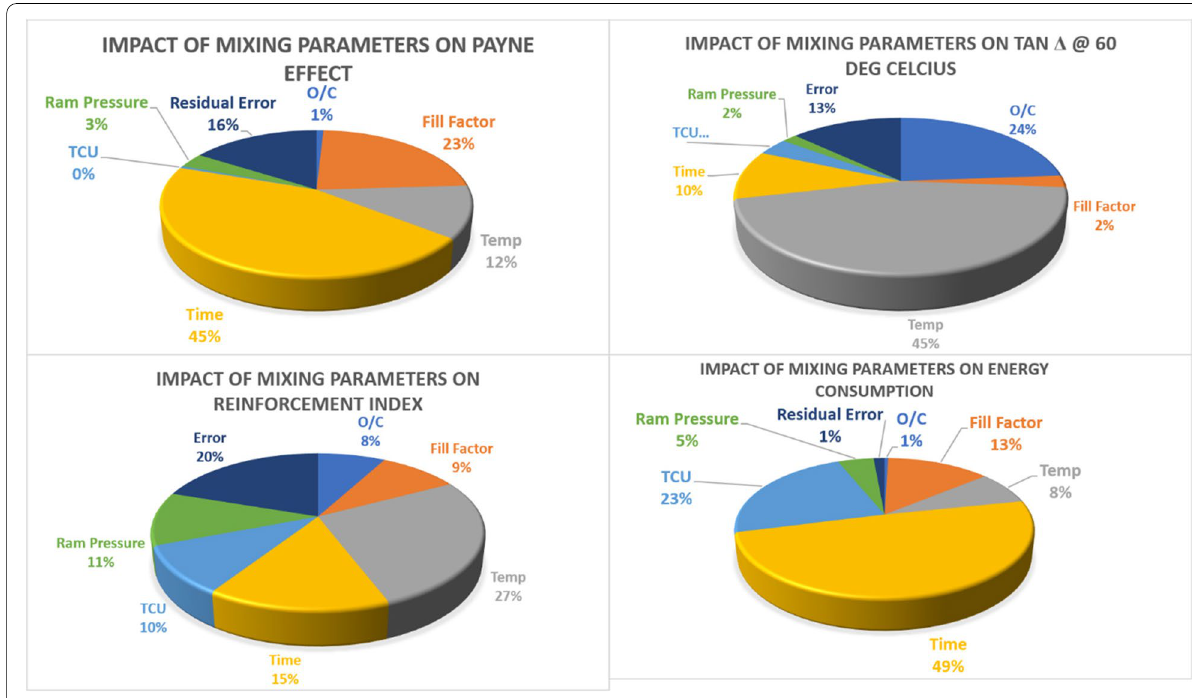
Fig. 11 Significance of mixing parameters on performance properties of silica‑filled SBR elastomer